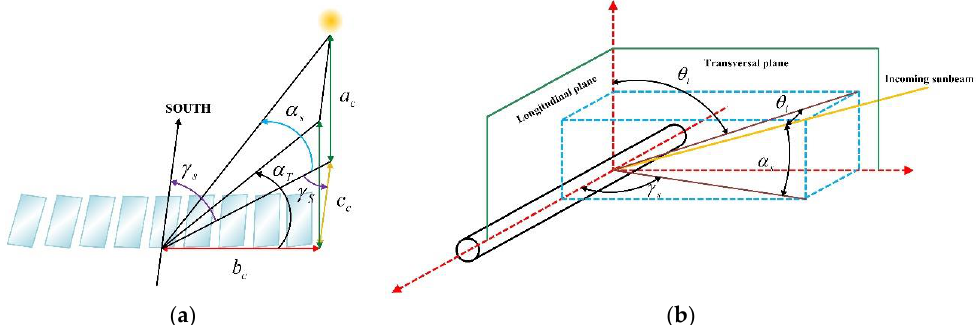
Figure 3. Angles in a LFR: ( a ) Determination of the transverse solar altitude angle; ( b ) Determination of the incidence angles.